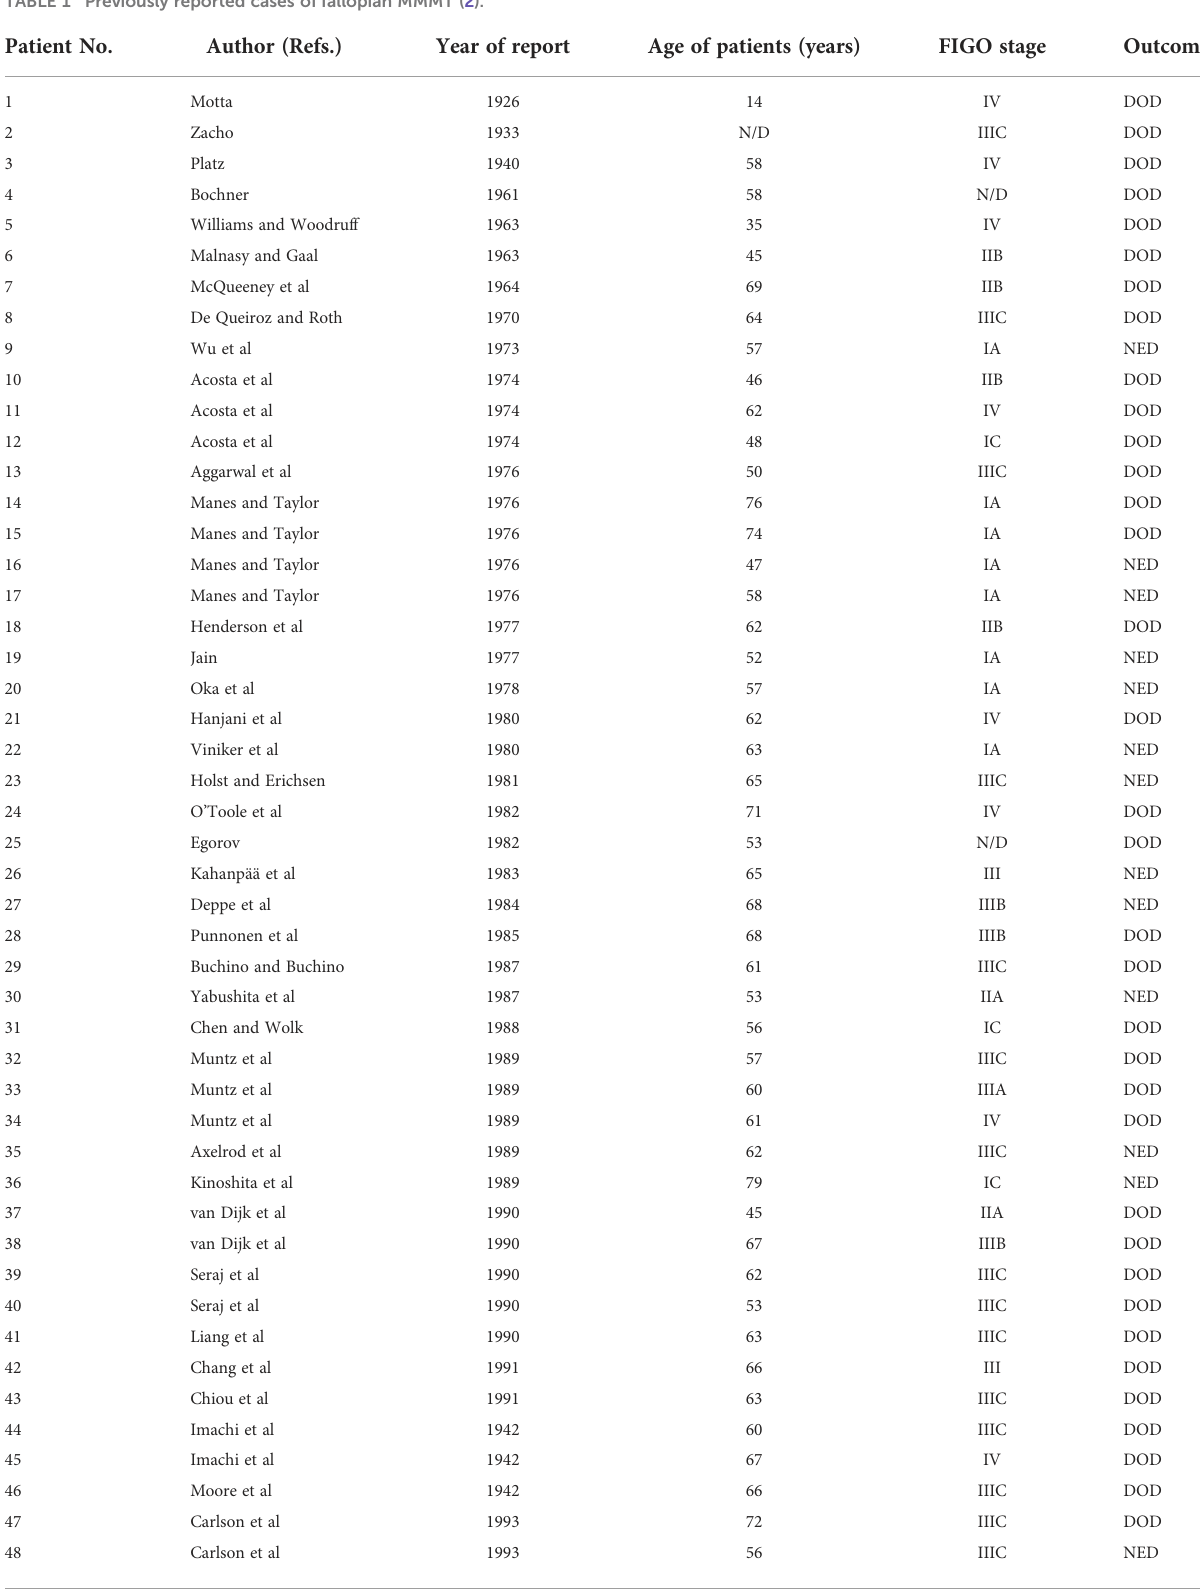
TABLE 1 Previously reported cases of fallopian MMMT (2). Patient No. Age of patients (years) FIGO stage